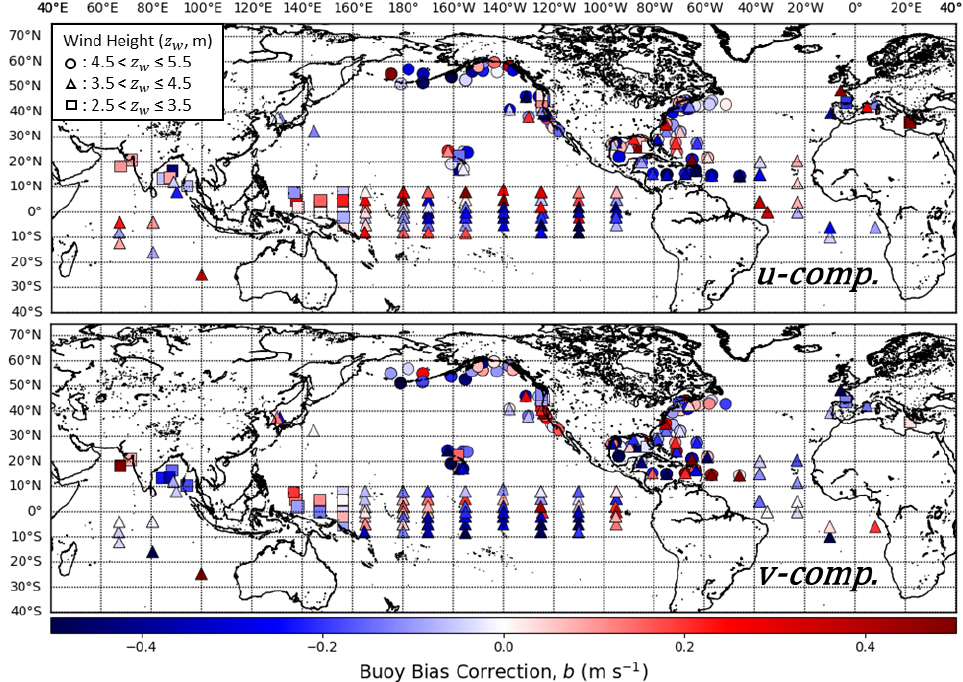
Figure 5. Triple collocation calibration scalings ( a ) of buoy 𝑈 (cid:2869)(cid:2868)(cid:3020) components calibrated with ASCAT winds as the standard for the full range of winds at the individual buoy level. The top sub- plot shows the calibration scalings for the u-component ( 𝑎 (cid:3048)(cid:3029)(cid:3048)(cid:3042)(cid:3052) ) and the bottom is the v-component scalings ( 𝑎 (cid:3049)(cid:3029)(cid:3048)(cid:3042)(cid:3052) ). Point shapes correspond to the buoy anemometer height ranges shown in the leg- end.